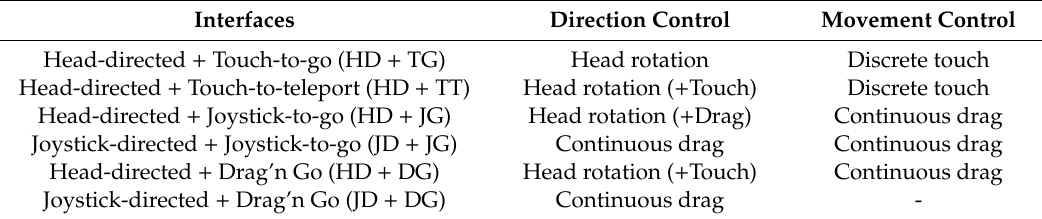
Table 1. The six navigation interface designs for EasyVR categorized by the methods used for the two subtasks of (1) direction control (rotation) and (2) invoking / controlling the